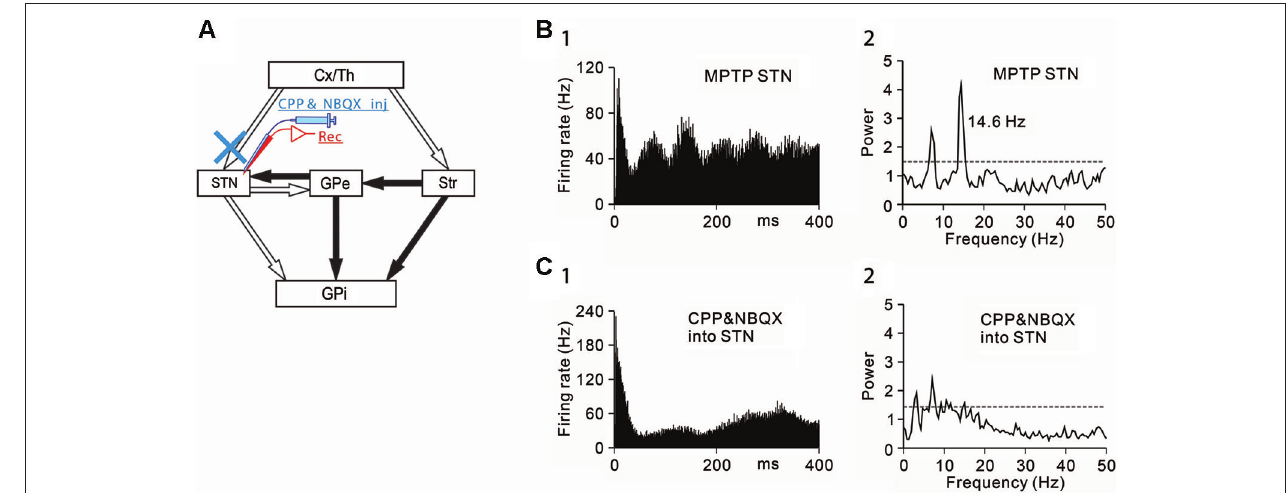
neuron showing abnormal oscillatory activity under the parkinsonian state. (C) Intrasubthalamic microinjection of CPP and NBQX decreased 3–8 Hz and 8–15 Hz oscillations of the STN neuron. Modified from Tachibana et al.